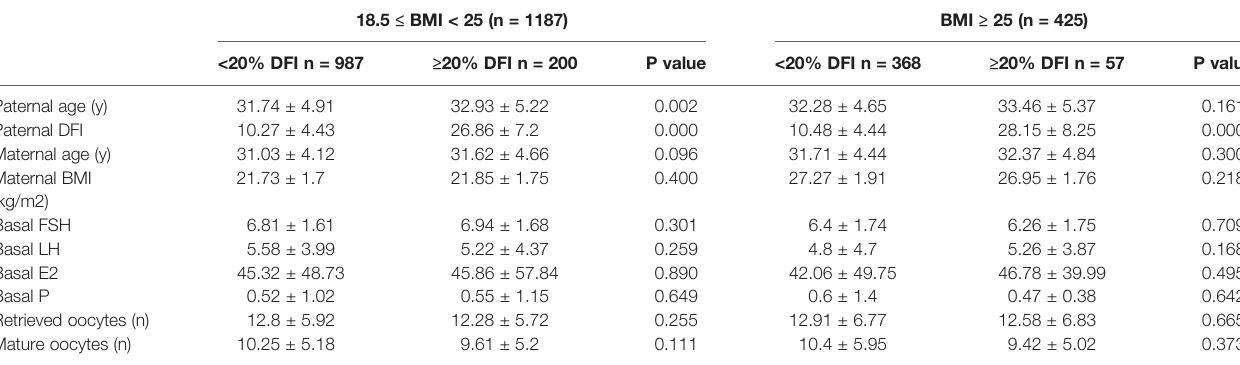
TABLE 2 | Baseline characteristics in each